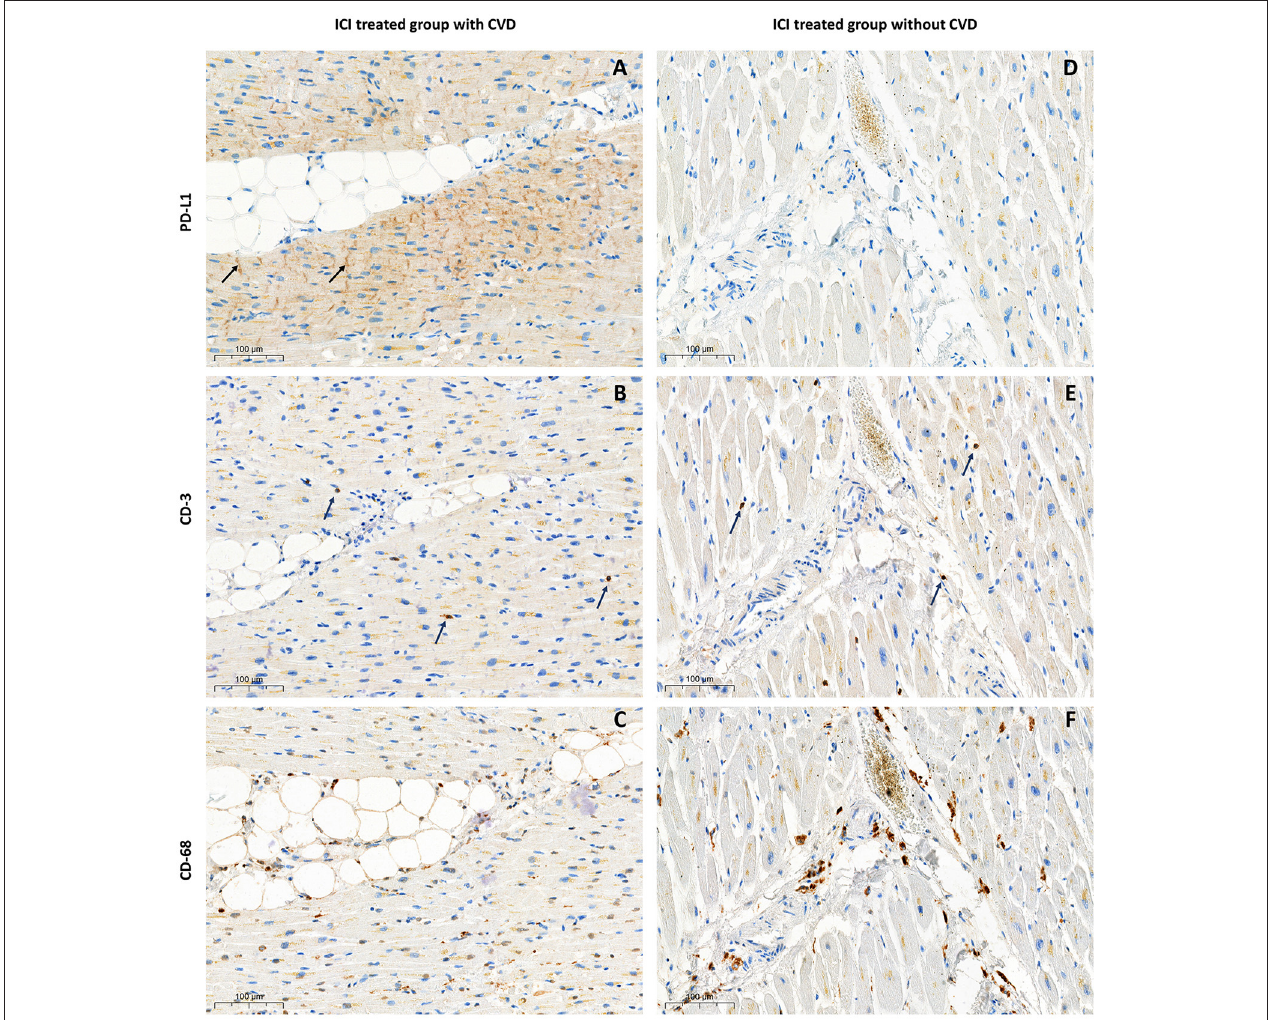
FIGURE 2 | Immunohistological examination of the myocardium samples from patients treated with ICI. With pre-existing CVD—left column (A) PD-L1 expression in ICD with CMPS 50%, ICDPS 40%; (B) CD-3 infiltration 7 cells per mm 2 ; (C) CD-68 infiltration 142 cells per mm 2 ; Without pre-existing CVD—right column (D) absence of PD-L1 expression; (E) CD-3 infiltration 17 cells per mm 2 ; (F) CD-68 infiltration 92 cells per mm 2